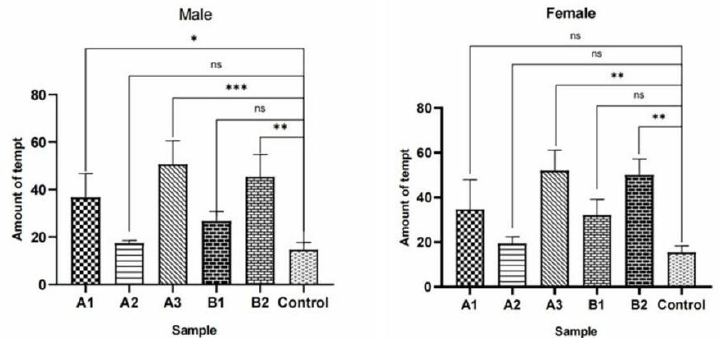
Figure 37. Attractive effects of different concentrations of methylheptenone and 1-octen-3-ol on W. magnifica . Note: A1: 10 − 1 µ g/ µ L methylheptenone; A2: 10 − 2 µ g/ µ L methylheptenone; A3: 1 µ g/ µ L methylheptenone; B1: 10 − 1 µ g/ µ L 1-octen-3-ol; B2: 1 µ g/ µ L 1-octen-3-ol; ns: no significant difference ( p > 0.05); *: significant difference (0.01 < p < 0.05); ** and ***: extremely significant difference ( p < 0.01). The same below.